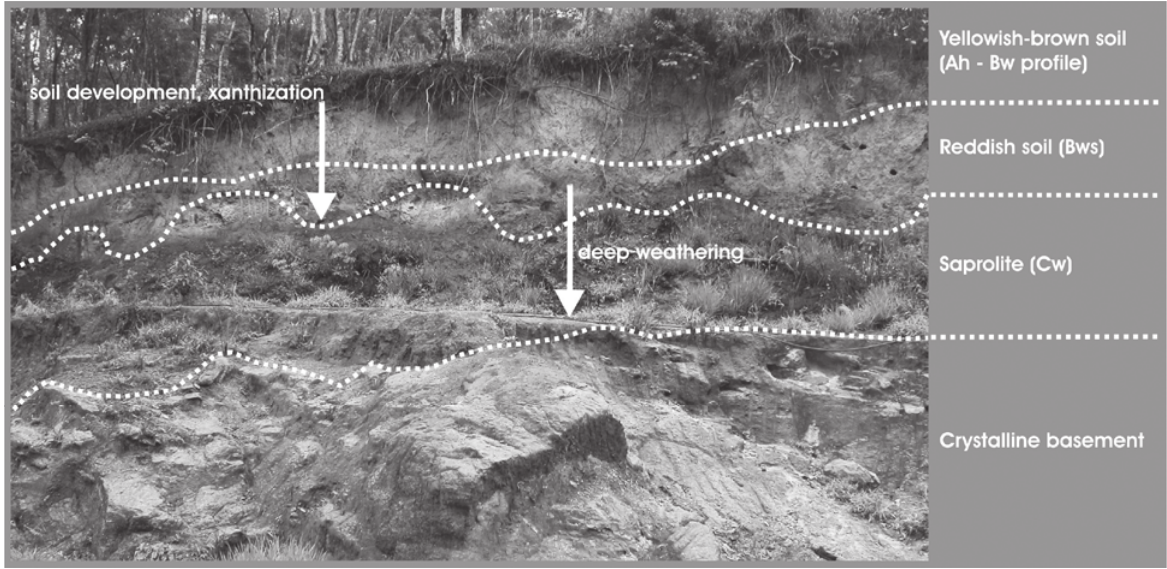
Figure 4 - Weathering profi le developed on granite. Profi le in the valley of Corrego Sujo, municipality of